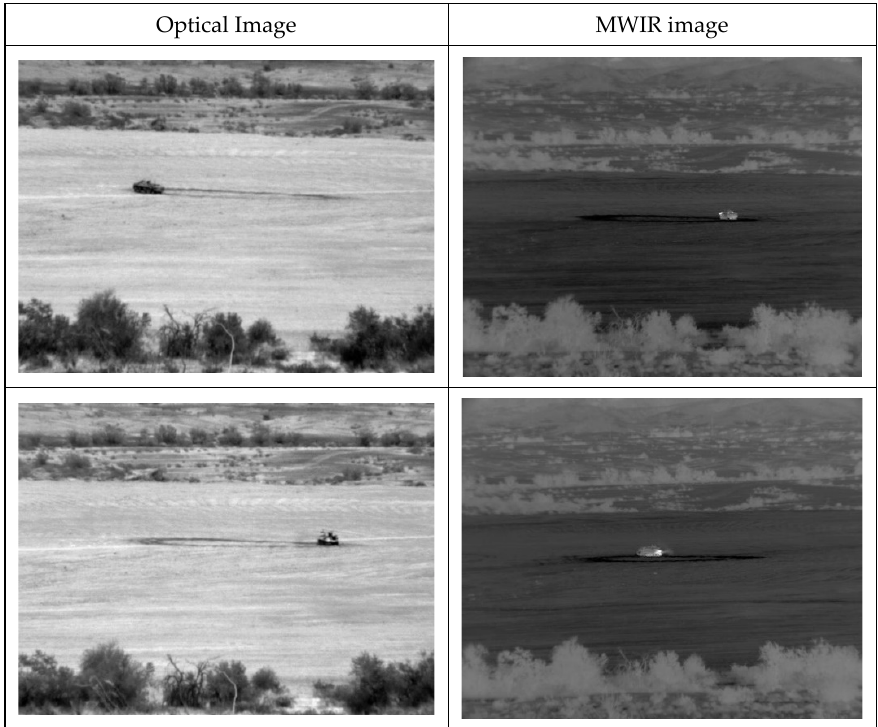
Figure 2. Unpaired training samples from optical and MWIR image domains.